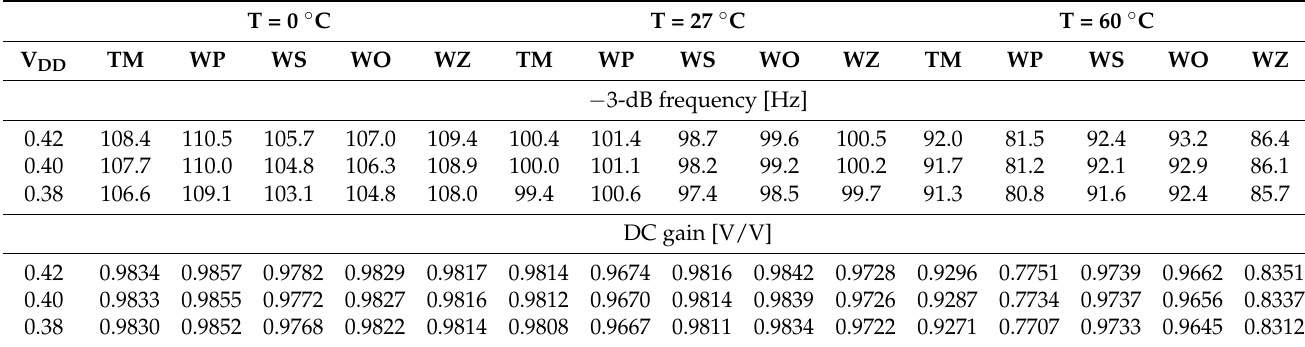
Table A2. Process (CMOS 180 nm X-FAB) corner simulation results for the cascade filter in Figure 8. T = 0 ◦ C T = 27 ◦ C T = 60 ◦